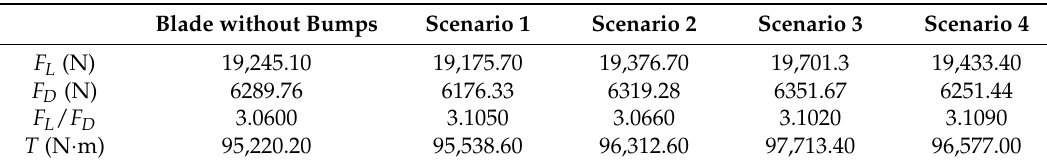
Table 4. The F L and F D acting on the blade.